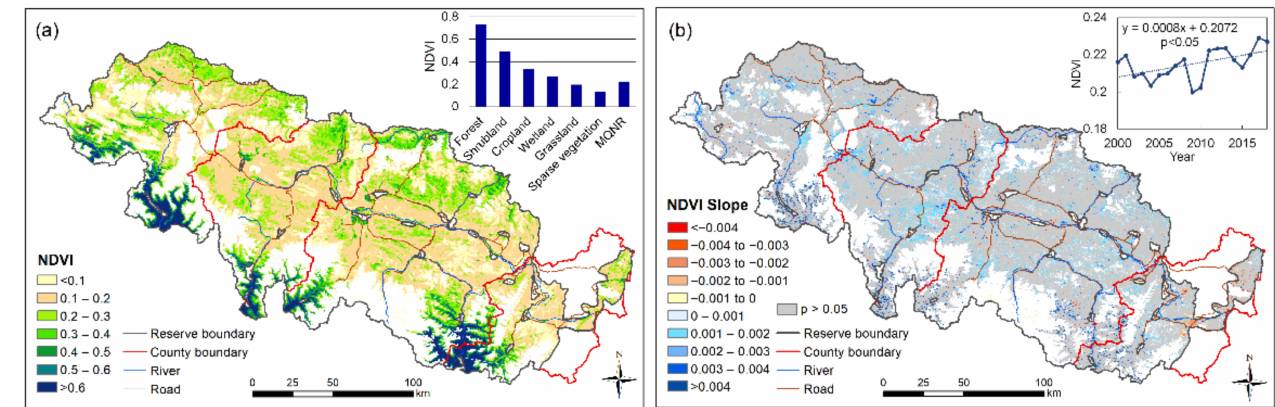
Figure 3. Spatial patterns of annual mean NDVI (left) and linear regression (right). The inset in ( a ) shows the average NDVIs of different vegetation types. The inset figure in ( b ) shows variations in the regional mean NDVI of the QNNP. Non-vegetation areas are masked out by white